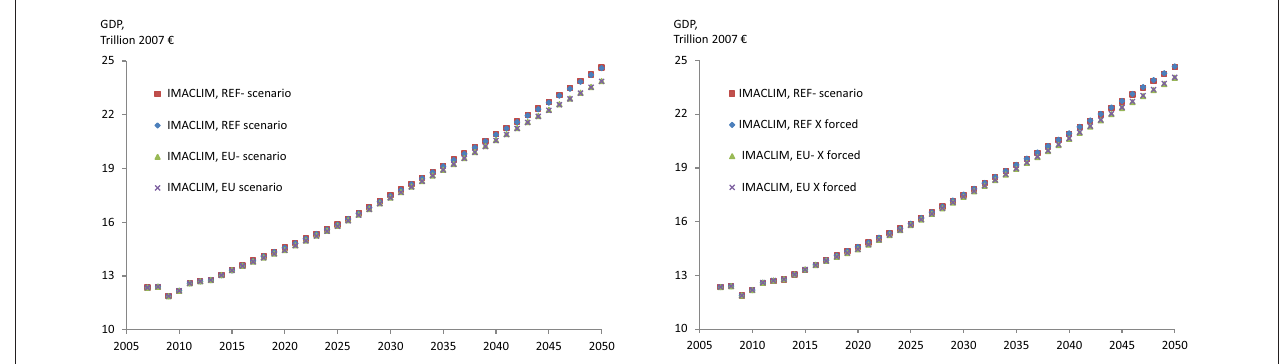
FIGURE 5 | EU28 growth trajectories under 4 scenarios and 3 forced exports variants. Computed from year-to-year real variations according to a chained Fischer GDP price index.